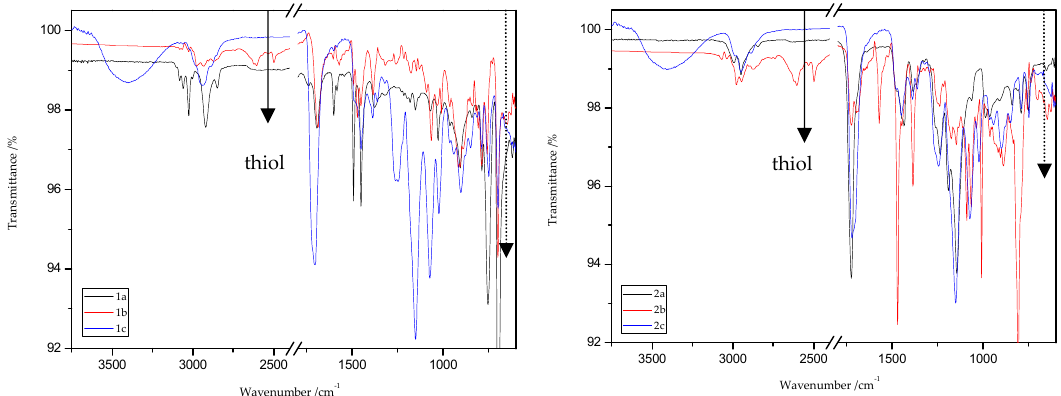
/ FT-IR spectra of ST (1a–c) and MMA (2a–c) copolymers. Materials 2020 , 13 , x FOR PEER REVIEW